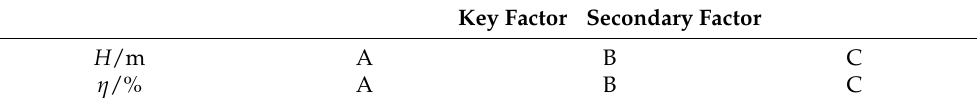
Table 7. The order of influence of the factors on pump performance at 0.6 Q des .